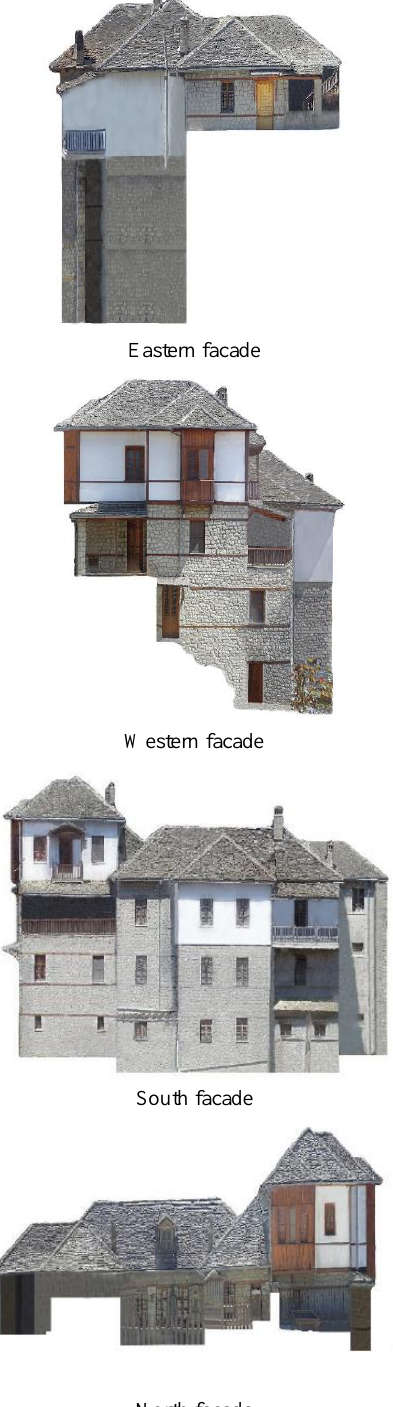
Figure 6: Orthoimages of the building facades